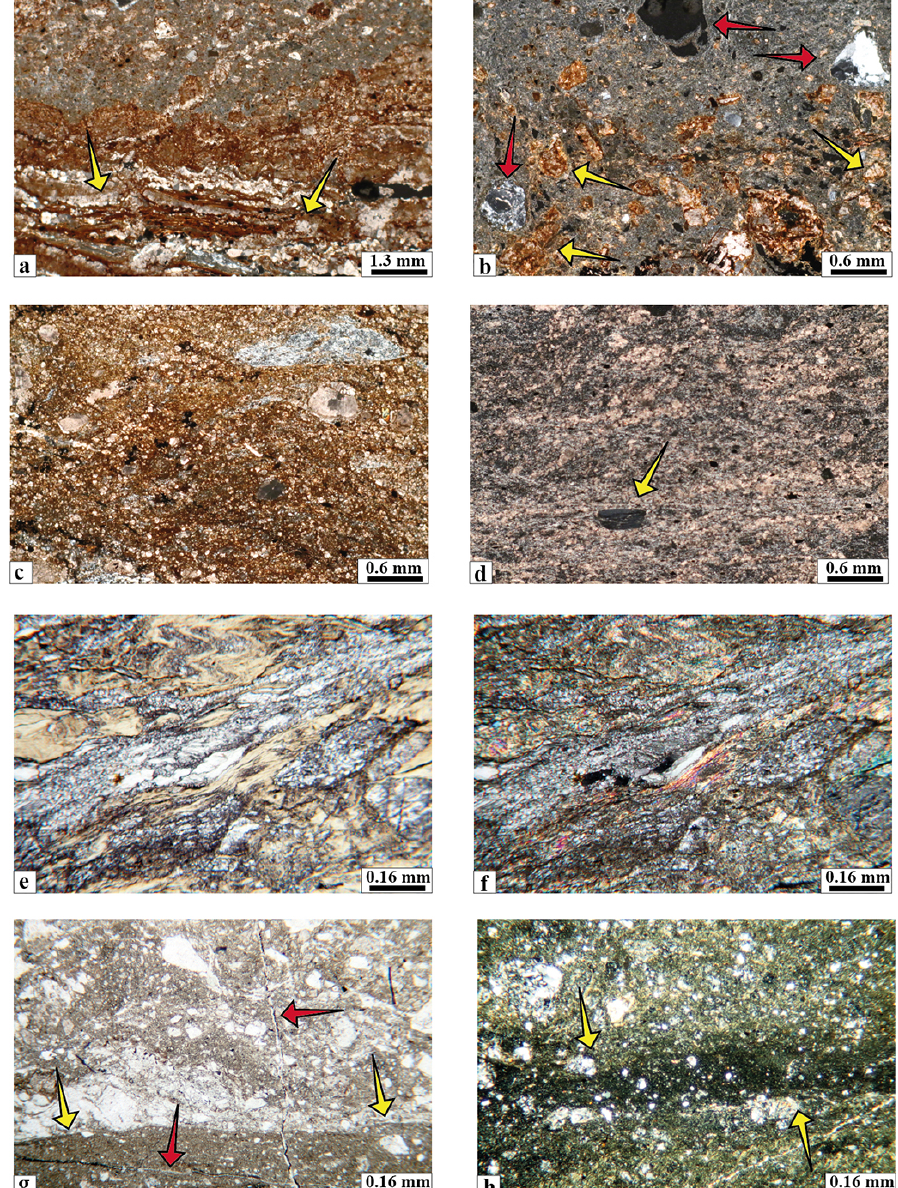
Figure 4. Microphotographs of representative examples of BSF fabrics. Panels (a–b) show BSF 1. (a) Very fine-grained matrix with extensive crystallization of secondary calcite and dolomite with sparse embedded euhedral dolomite grains (grey layer, upper half of photo) and Fe oxide and hydroxide alteration (reddish layer, lower half of photo). Relic foliated cataclastic domains (indicated by the yellow arrows) alternate with Fe hydroxide bands and dolomite veins shown using plane polarized light (PPL). (b) Cataclasite with rare quartz–feldspar clasts (red arrows) in a very fine-grained matrix characterized by diffuse recrystallization of secondary calcite and dolomite (lower half of the photo) also occurring as euhedral grains (yellow arrow) shown using crossed polarized light (CPL). Panels (c–d) show BSF 2. (c) Foliated cataclasite with preserved fine-grained quartz clasts and carbonate euhedral grains. The fine-grained matrix consists of secondary calcite shown using PPL. (d) Very fine-grained phyllosilicate-, calcite-, and dolomite-rich cataclasite matrix enveloping phyllite clasts (yellow arrow). Diffuse occurrence of coarse-grained secondary calcite in the upper half of photo shown using CPL. Panels (e–f) show BSF 3. (e) Very fine-grained talc phyllonite; talc-serpentine-rich yellowish layers alternate with whitish very fine-grained (10–15µm) calcite-rich layers shown using PPL. Panel (f) is the same image as (e) but using CPL. Panels (g–h) show BSF 4. (g) Clast-rich foliated cataclasite with a very fine-grained phyllosilicate-rich matrix (upper half of photo) in sharp contact with matrix-rich ultracataclasite marked by significant grain size reduction and well-rounded clasts (yellow arrows). Very thin calcite veins cut across the cataclasite fabric (red arrows) shown using PPL. (h) Quartz–feldspar cataclasite with a very fine-grained phyllosilicate-rich matrix, enclosing a very thin (100–150µm) ultracataclasite layer (yellow arrows) shown using CPL. Solid Earth, 13, 1327–1351, 2022